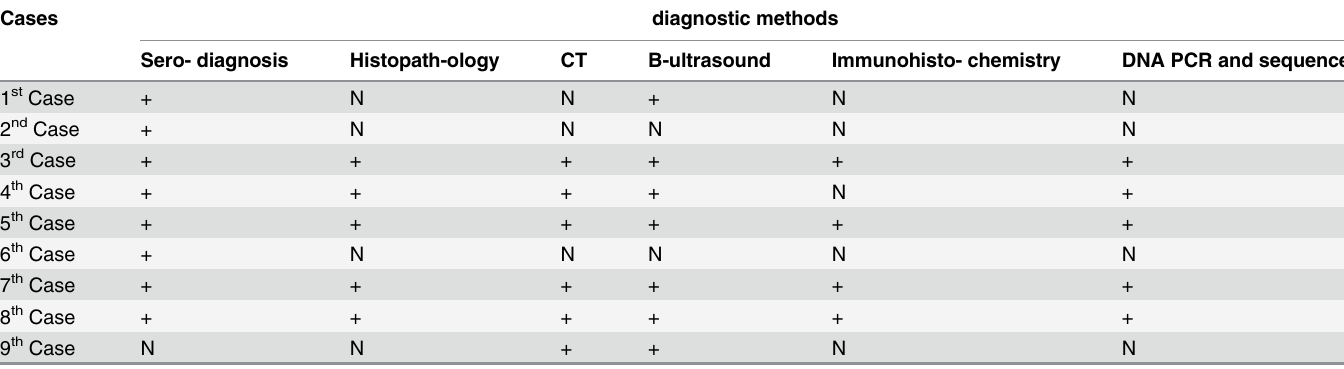
Table 1. The diagnostic methods for the 9 AE cases.